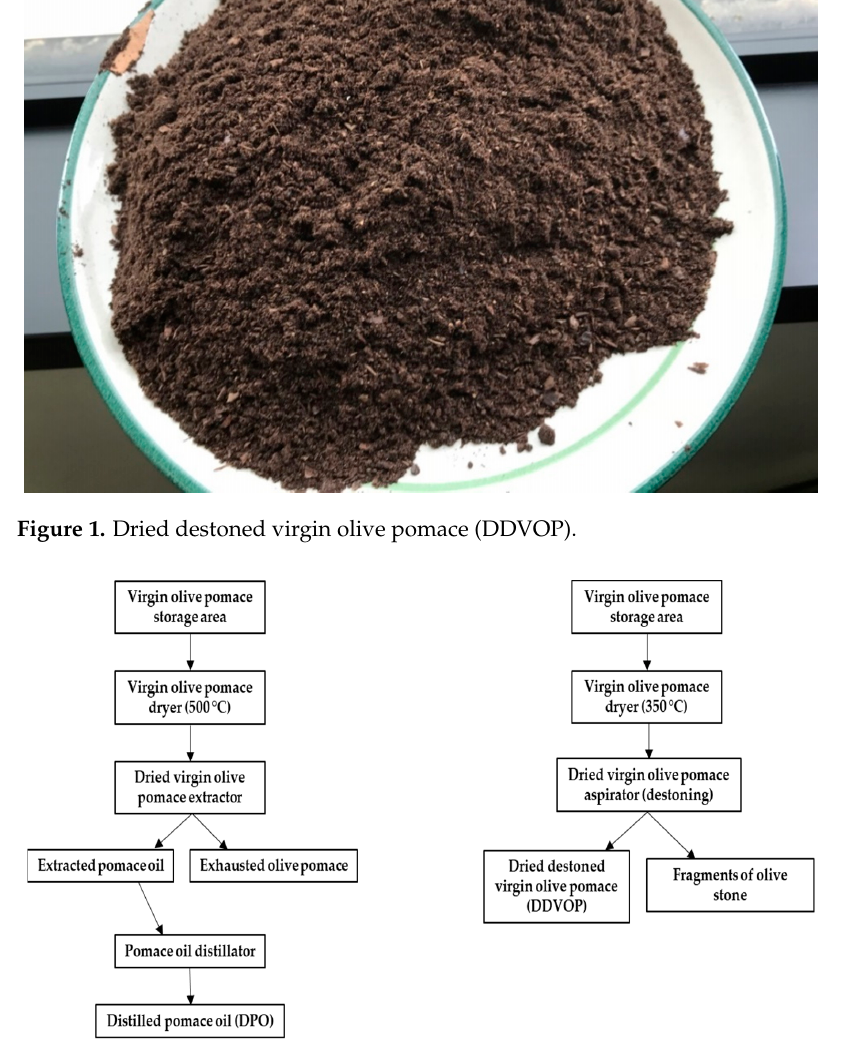
Figure 2. Simplified olive pomace flow sheet: ( left ) traditional flow; ( right ) innovative flow leading to the dried destoned virgin olive pomace (DDVOP) production.